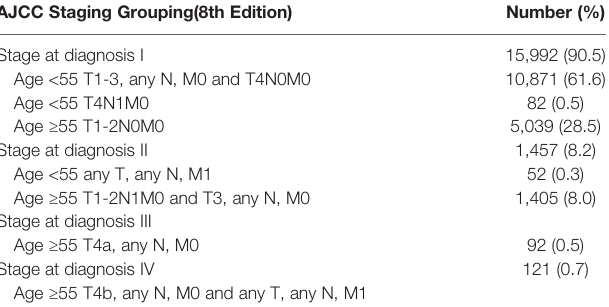
TABLE 2 | Demographic characteristics of each subgroup patients with FVPTC.